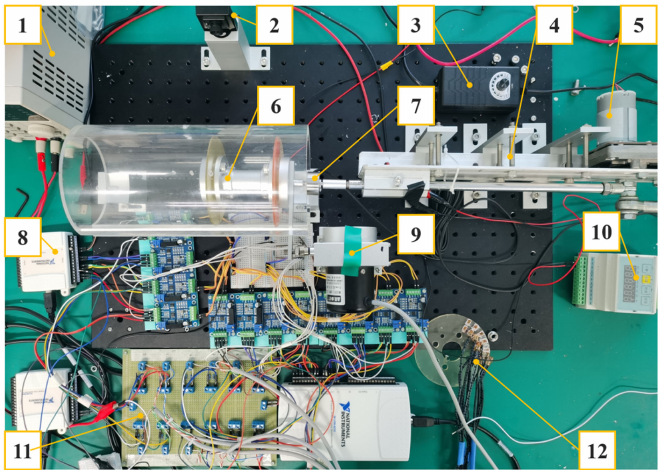
Figure 8. Schematic diagram of the test platform ( left ) and the parallel signal processing circuit design ( right ).